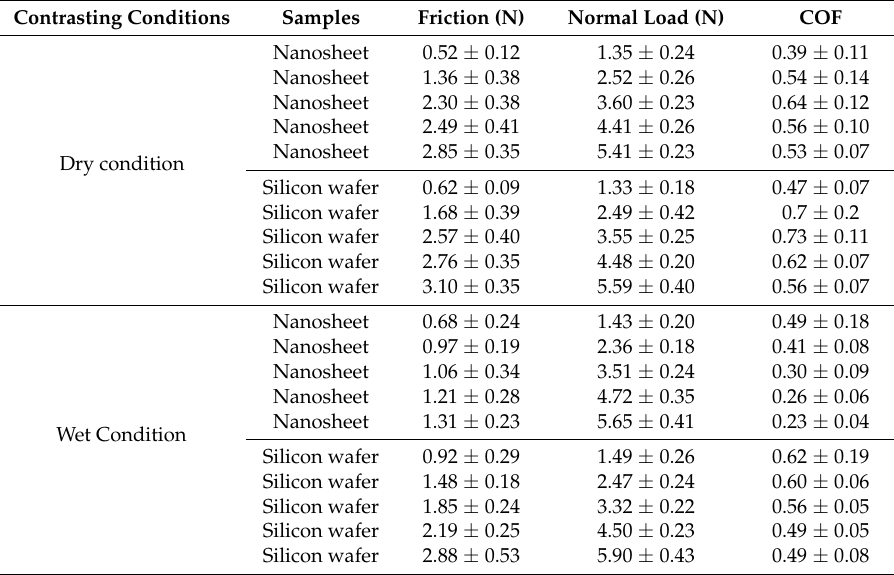
Table 1. Experimental data of friction measurements under the dry and wet